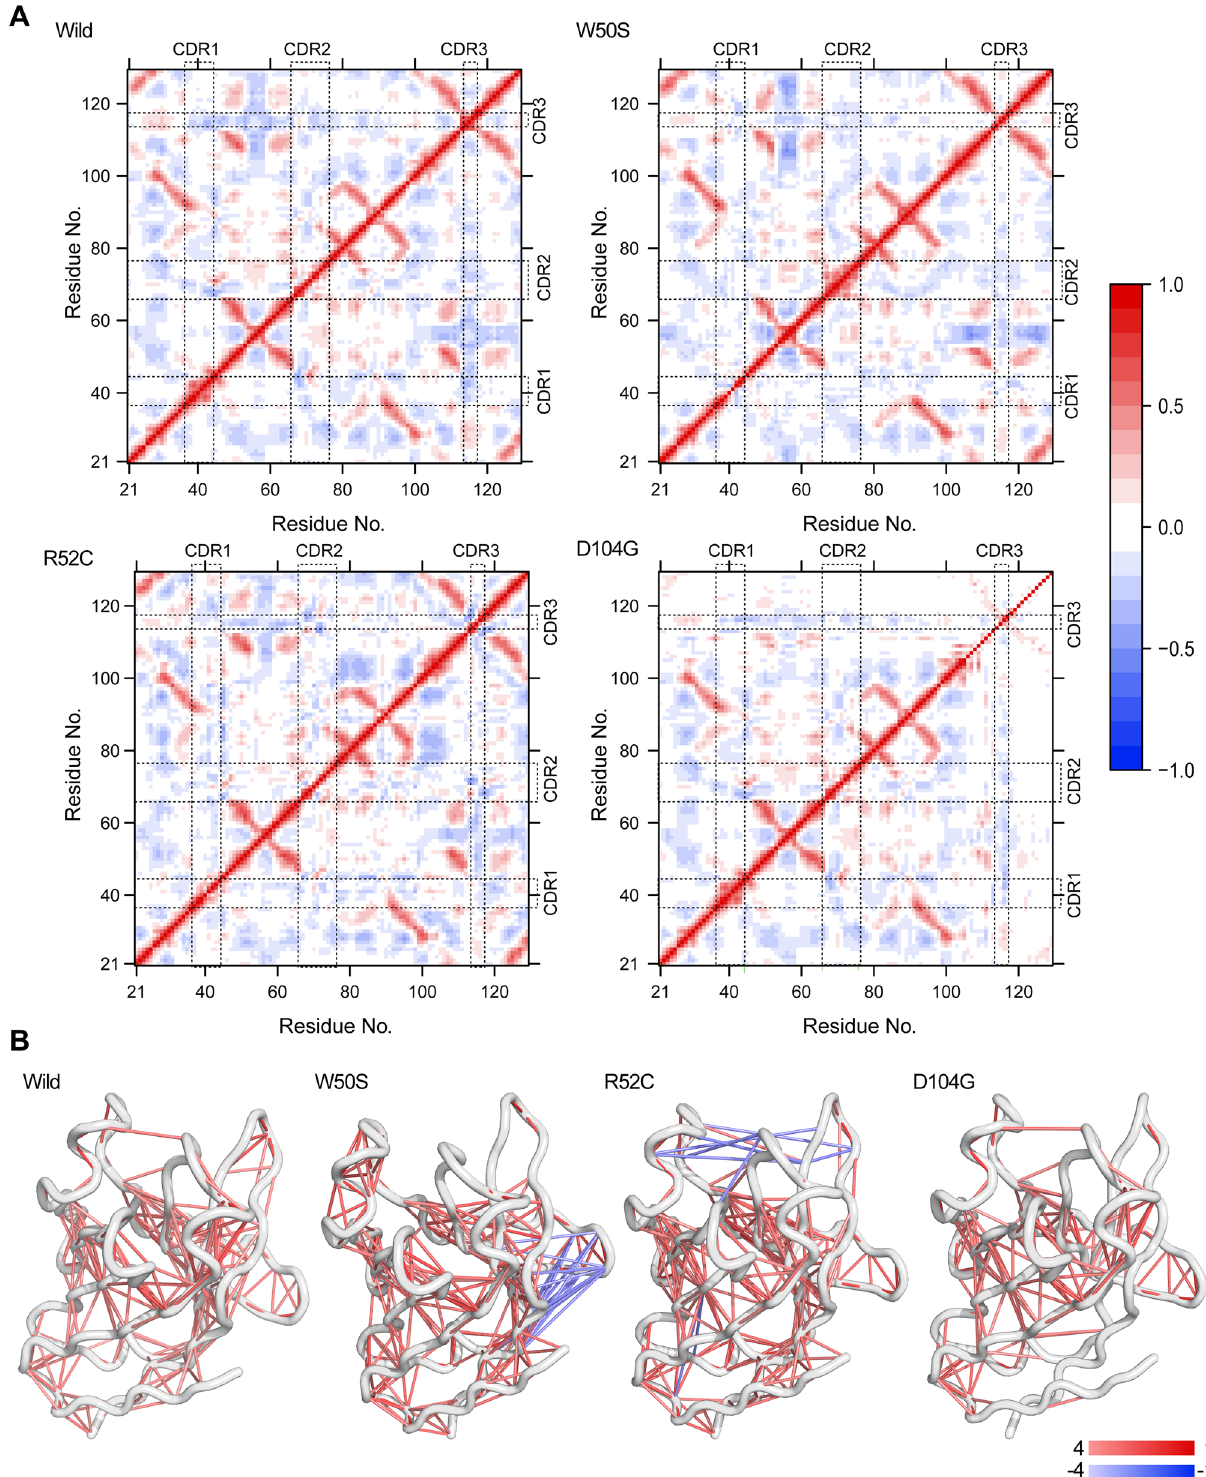
Figure 4. Alterations in the correlated motions in TREM2 variants. ( A ) The dynamic cross-correlation matrix (DCCM) plot shows anticorrelated and correlated motions between every two residues in the structure. Here a perfect correlated motion is denoted by red (+ 1), and an anticorrelated motion by blue (− 1). CDRs are indicated by dotted boxes. ( B ) DCCM representation in the structural view of TREM2, where lines denote correlations between two residues. A blue line indicates anticorrelated motions, and a red line denotes positive correlations. Color intensities indicate strengths of